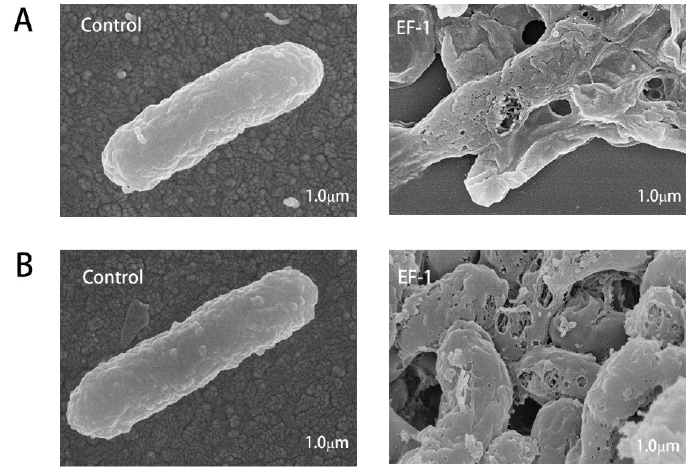
Figure 5. Scanning electron microscopy of EHEC ( A ) and E. coli K88 ( B ) cells treated with hybrid EF-1 for 2 h. Scale bars: 1.0 μm.